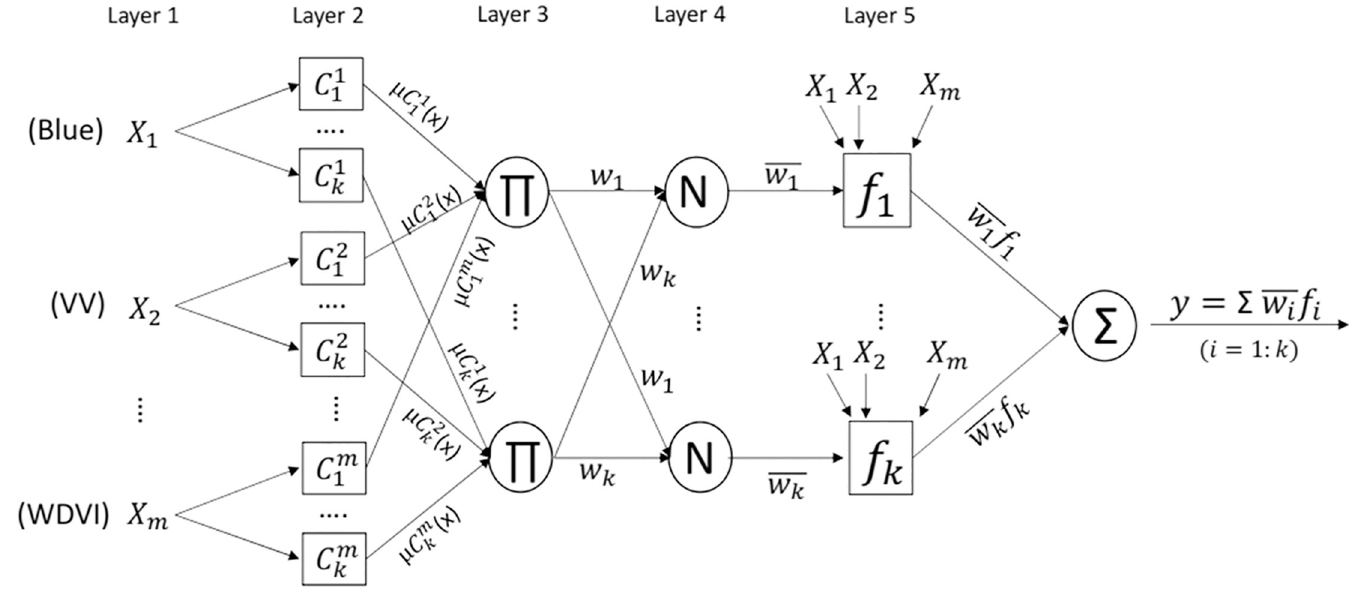
Fig 2. Adaptive neuro-fuzzy inference system.